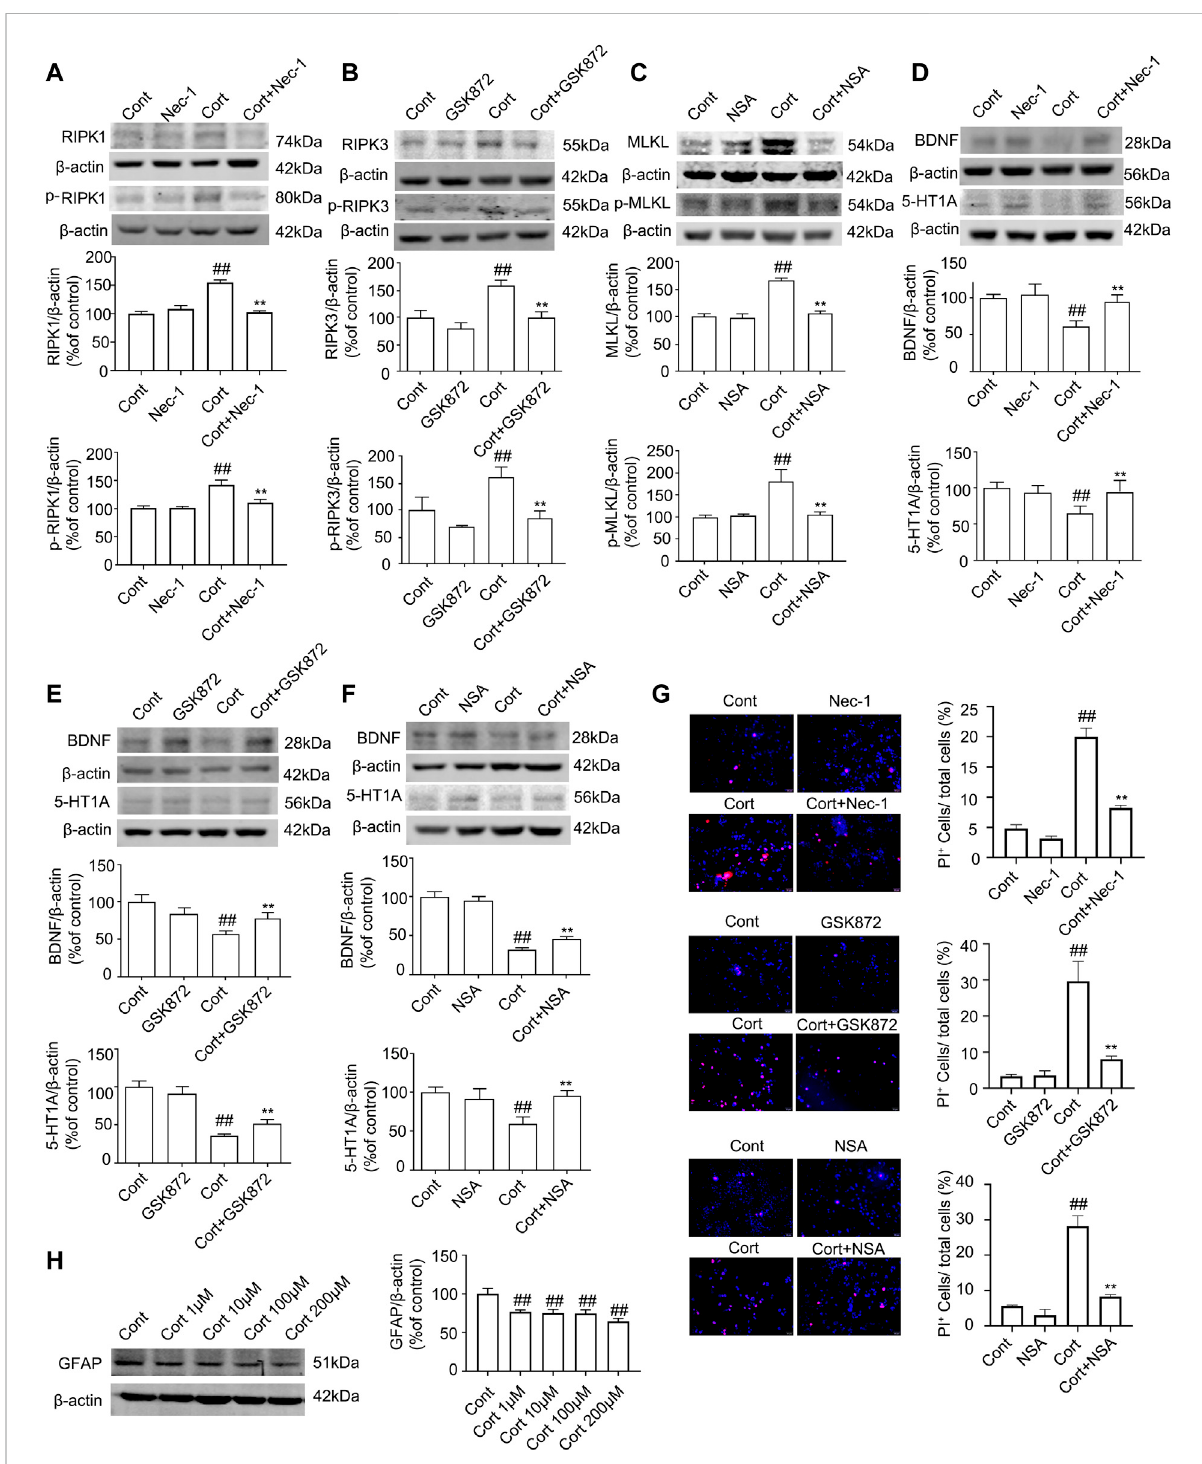
Necroptotic kinase inhibitors suppress corticosterone (Cort)-induced necroptotic kinase activation and protect Cort-treated astrocytic necroptosis in human astrocytes (HAs). HA was exposed to 200 μ M Cort for 1 h to induce cell injury. HA was treated with 100 μ M Nec-1, 10 μ